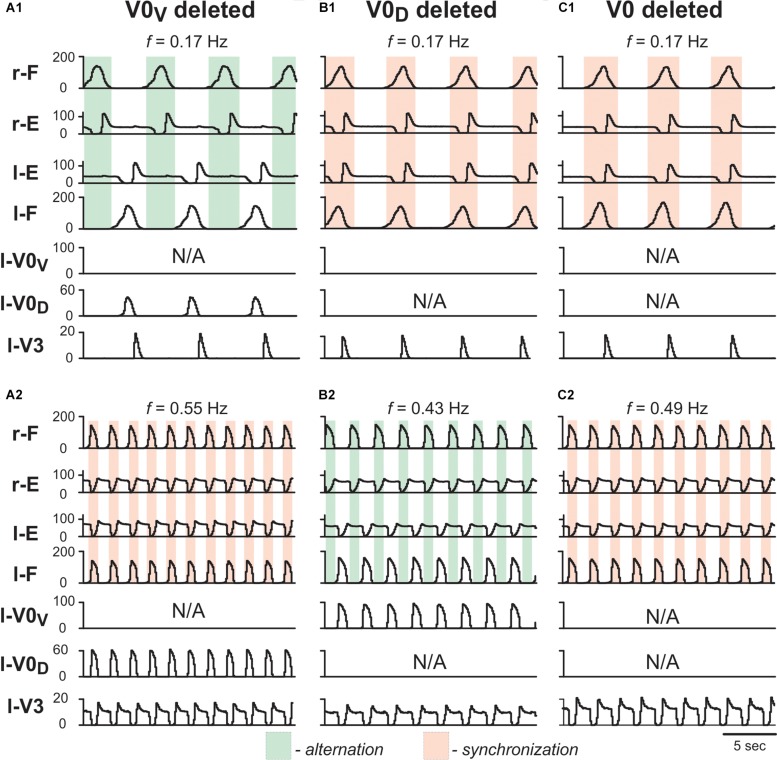
Model performance after removal of V0V, V0D and all V0 commissural interneurons. Integrated population activities of flexor and extensor rhythm generator centers (F and E, respectively) and left commissural interneurons are shown after removal of V0V
(A1,A2), V0D
(B1,B2), and all V0 (C1,C2), at a low (A1,B1,C1; α = 0.01) and a high (A2,B2,C2; α = 0.08) excitation level and oscillation frequency. Shaded areas show intervals of right flexor activities. Green indicates left–right alternation and pink left–right synchronization. r-: right; l-: left.